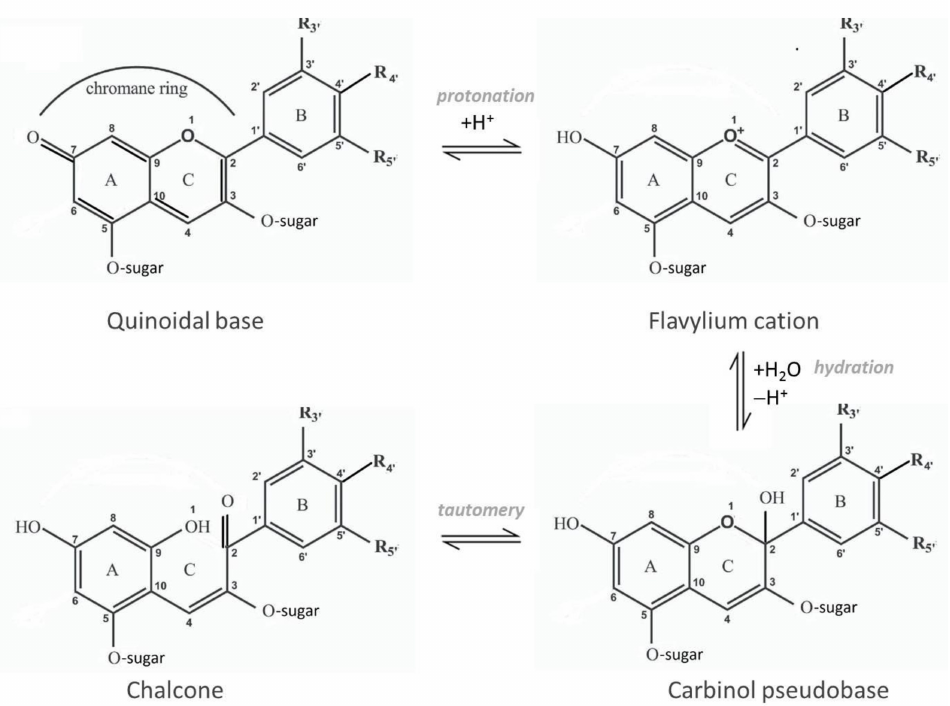
Figure 1. Structural reversible chemical transformations of